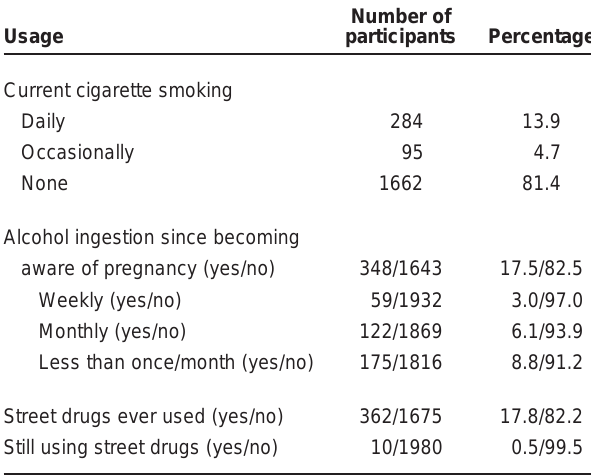
TABLE 3 History of cigarette, alcohol and drug use of participants in the Edmonton Perinatal